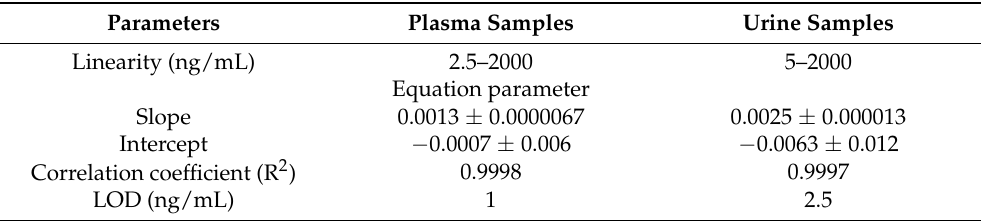
Table 2. Validation data for the DLLME-LC–M/MS method in the determination of DOC in plasma and urine samples (n = 6).